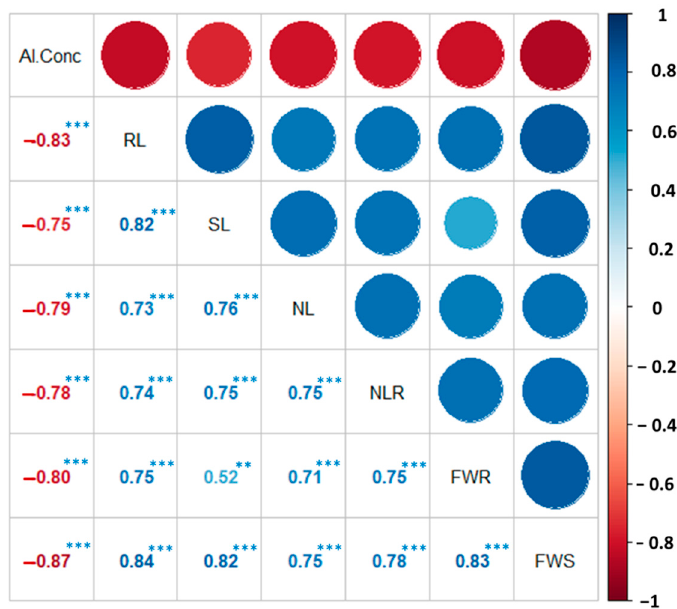
Figure 3. Correlation analysis among phenotypic traits and Al concentrations of chickpea genotypes combined for all the six Al concentrations. Al. Conc, Al concentrations; RL, root length; SL, shoot length; NL, number of leaves; NLR, number of lateral roots; FWR, fresh weight roots; FWS, fresh weight shoots. Significance codes: ‘***’ 0.001; ‘**’ 0.01.